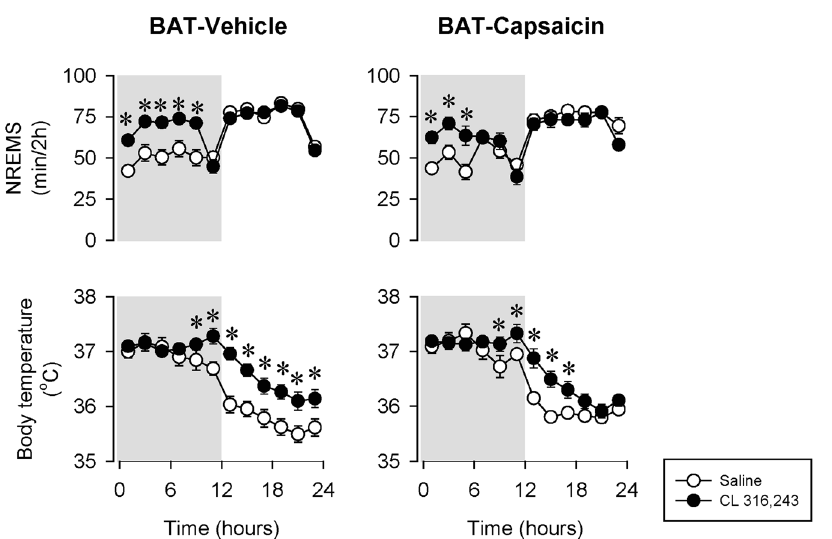
Figure 8. The effects of the selective β 3-AR agonist CL-316,243 on NREMS and body temperature in mice with the chemical deafferentation of the intra-scapular BAT pads (BAT-Capsaicin; black symbols) and control mice (BAT-Vehicle; open symbols). See Fig. 1 for